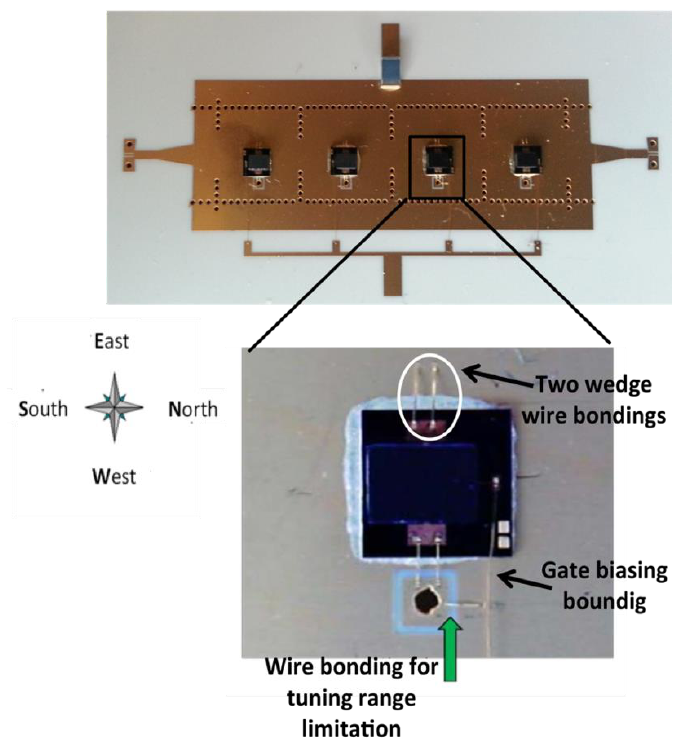
Figure 7. Photograph of the RF-MEMS-based tunable bandpass filter and zoom on the mounted RF-MEMS switch with the additional wire bonding.